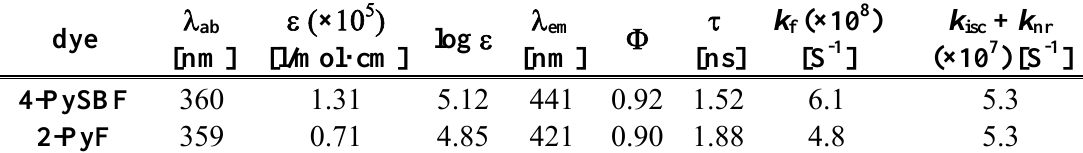
Table 1. Photochemical data for compounds 4-PySBF and 6